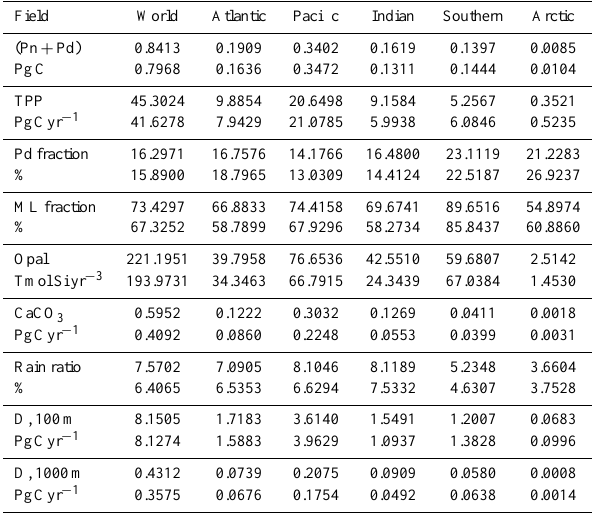
Table 8. Mean annual (2000–2004) biogeochemical properties in M EDUSA -1.0 (upper row) and M EDUSA -2.0 (lower row). Units in- dicated for each